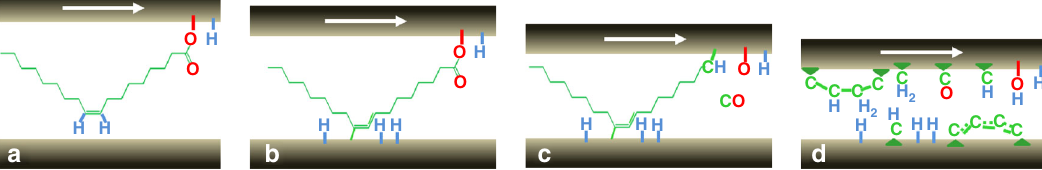
Fig. 6 Schematic representation of the mechano-chemical fragmentation of oleic acid between two sliding ta-C surfaces and of the resulting surface